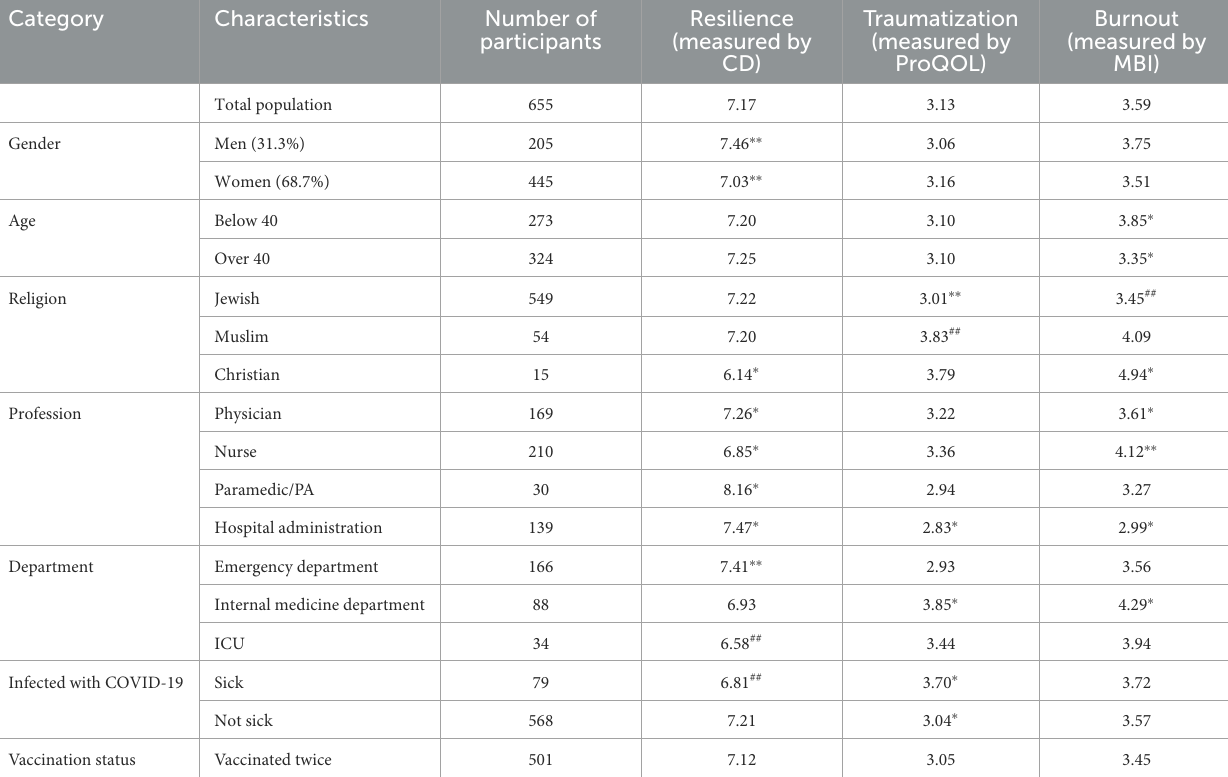
TABLE 1 Distribution of resilience traumatization and burnout scores by population subgroups and characteristics (average, P -value). Category